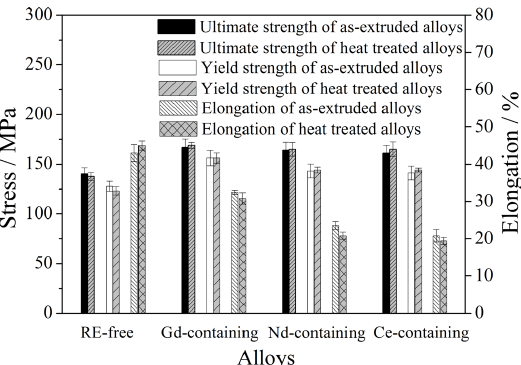
Figure 8. Comparison of mechanical properties between as extruded and heat treated RE-containing